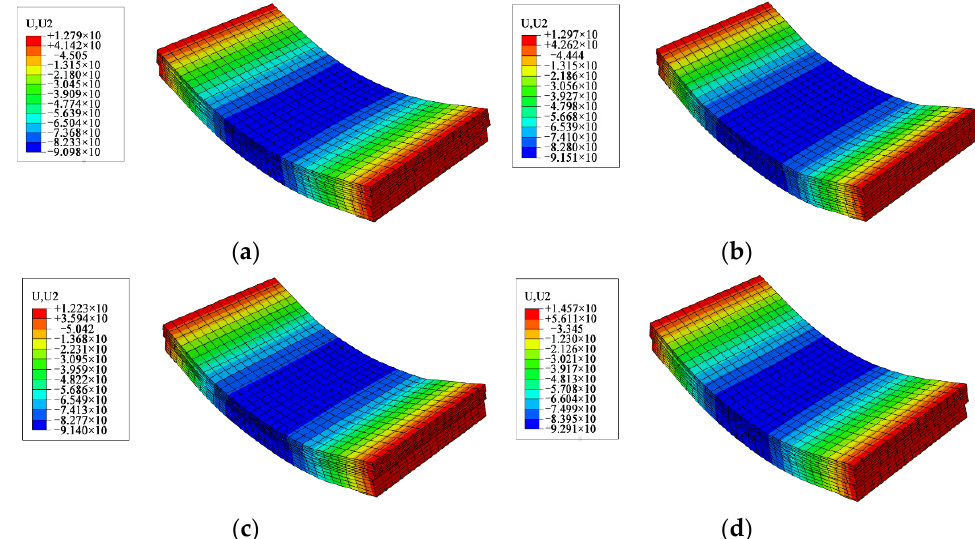
Figure 12. Displacement cloud diagram of finite-element model: ( a ) SP-1; ( b ) SP-2; ( c ) SP-3; ( d ) SP-4.